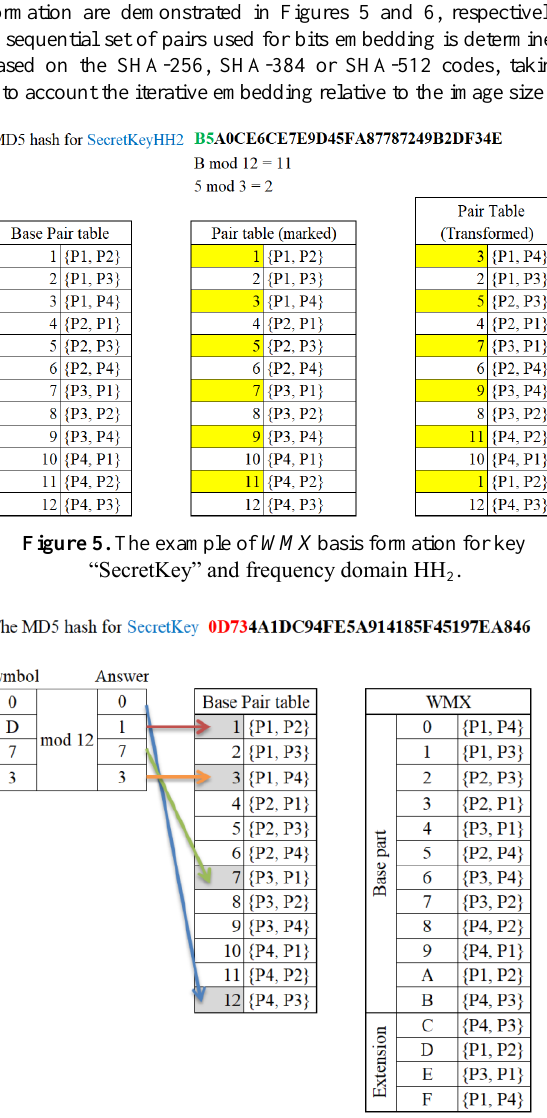
Figure 6. The example of WMX formation for key “SecretKey” and frequency domain HH 2